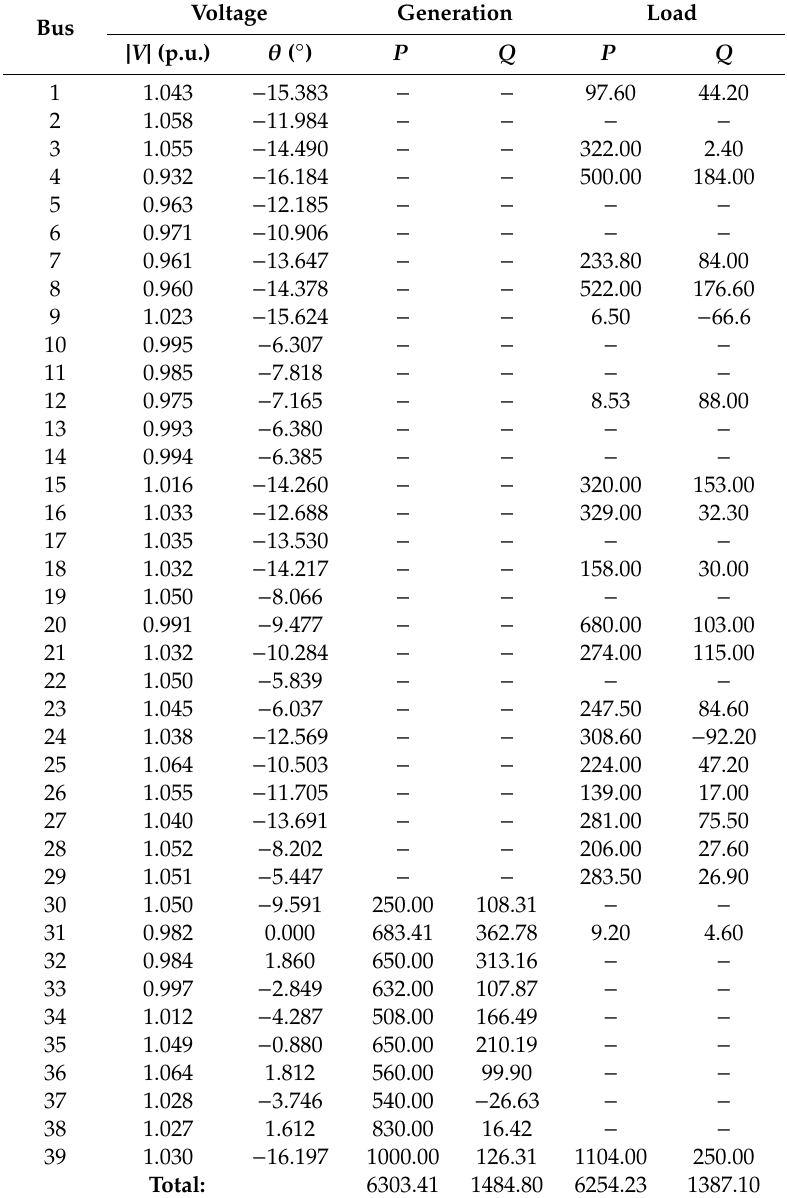
Table A44. Results of Mixed AC / DC PF calculations in Case 7-4. AC bus